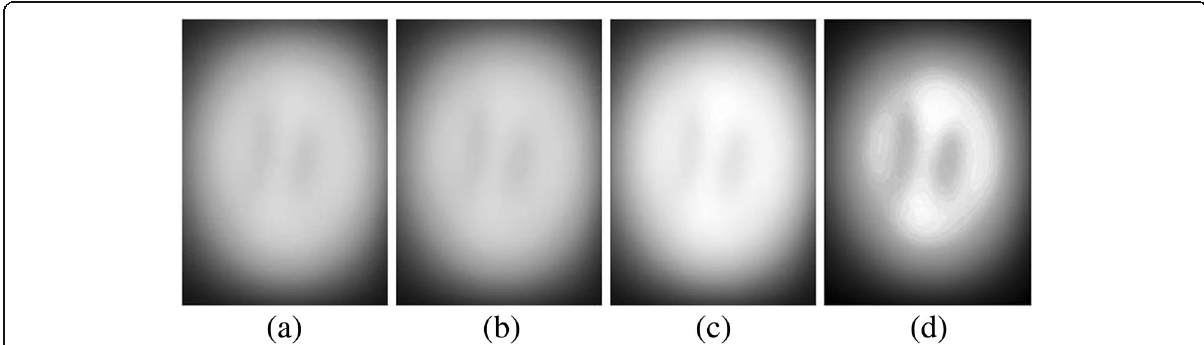
Fig. 6 Comparison of each filtering method with the preprocessing algorithm in this paper. ( a ) is the original image, ( b ) is the median filtered image, ( c ) is the Gaussian filtered image, and ( d ) is the image processed by the preprocessing algorithm of this paper